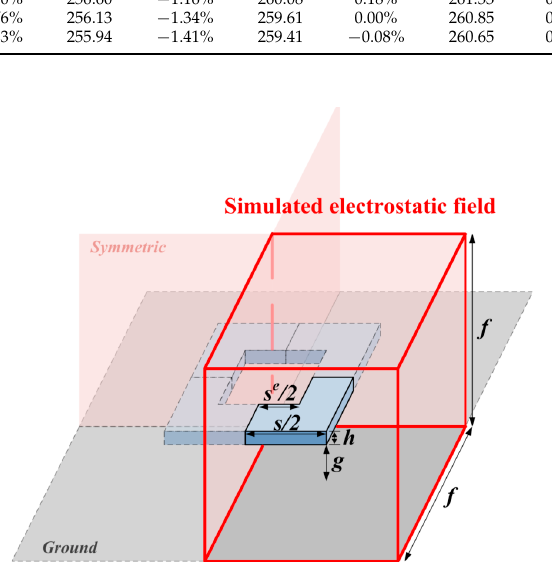
Figure 5. Scheme of simulation model. f : Length of the cubic region of the electrostatic field in simulation.